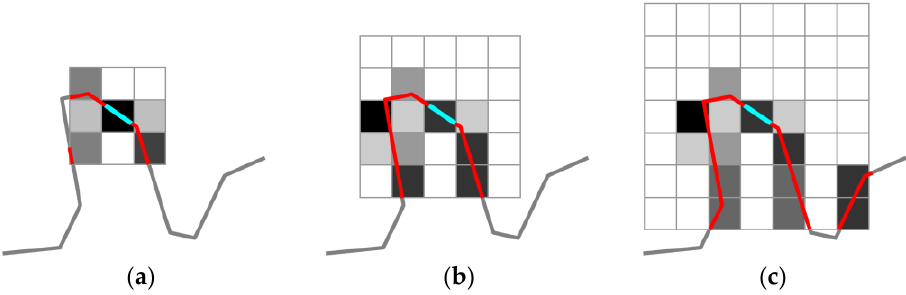
Figure 15. Grid shape context descriptors (GSCDs) with different sized grids for each lixel: ( a ) grid size of 3 × 3; ( b ) grid size of 5 × 5; ( c ) grid size of 7 × 7.